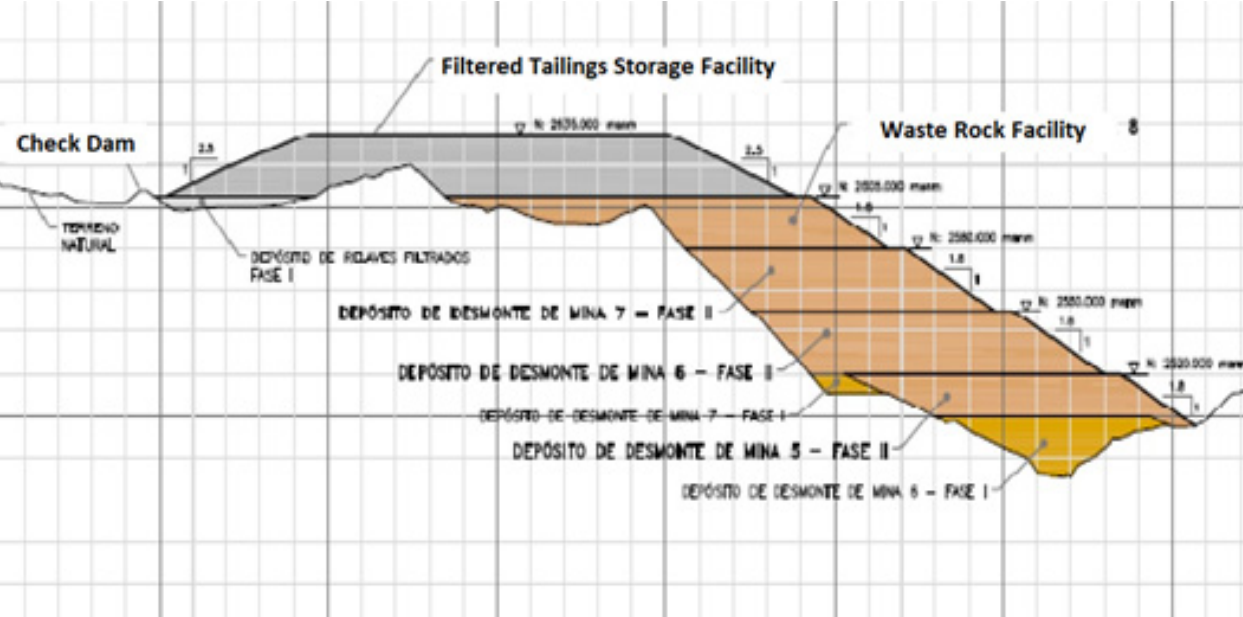
Figure 65. Curaubamba Filtered TSF–Typical Cross Section [38,39].